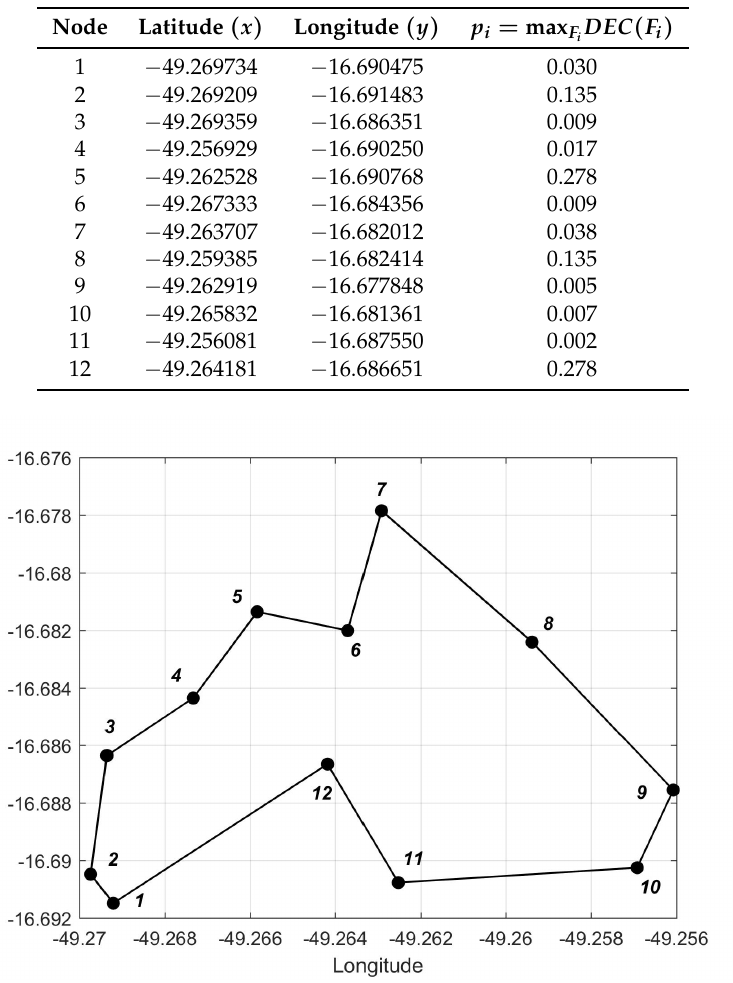
Table 1. Coordinates and p i of network nodes.